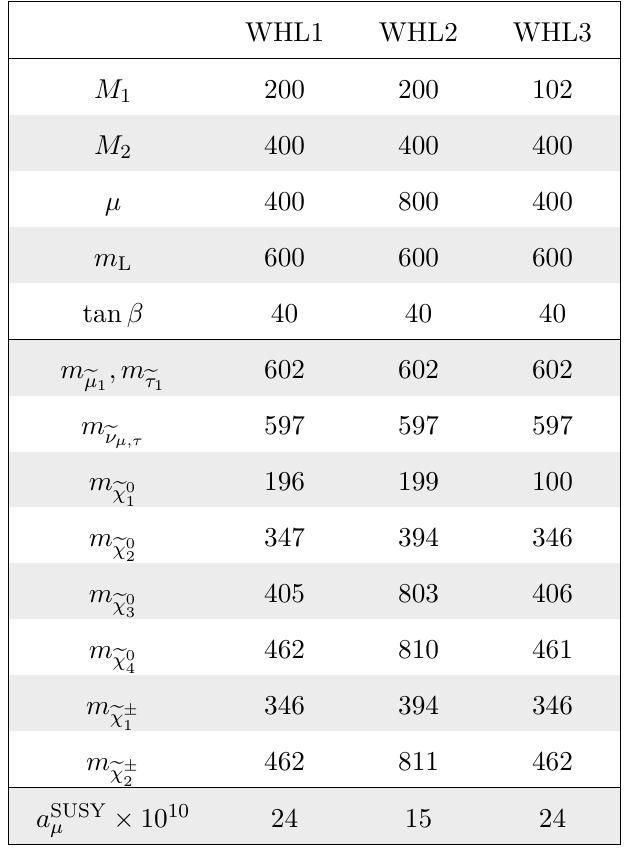
Table 1. Benchmark points for the chargino-contribution dominated scenario. The mass parame- ters are in units of